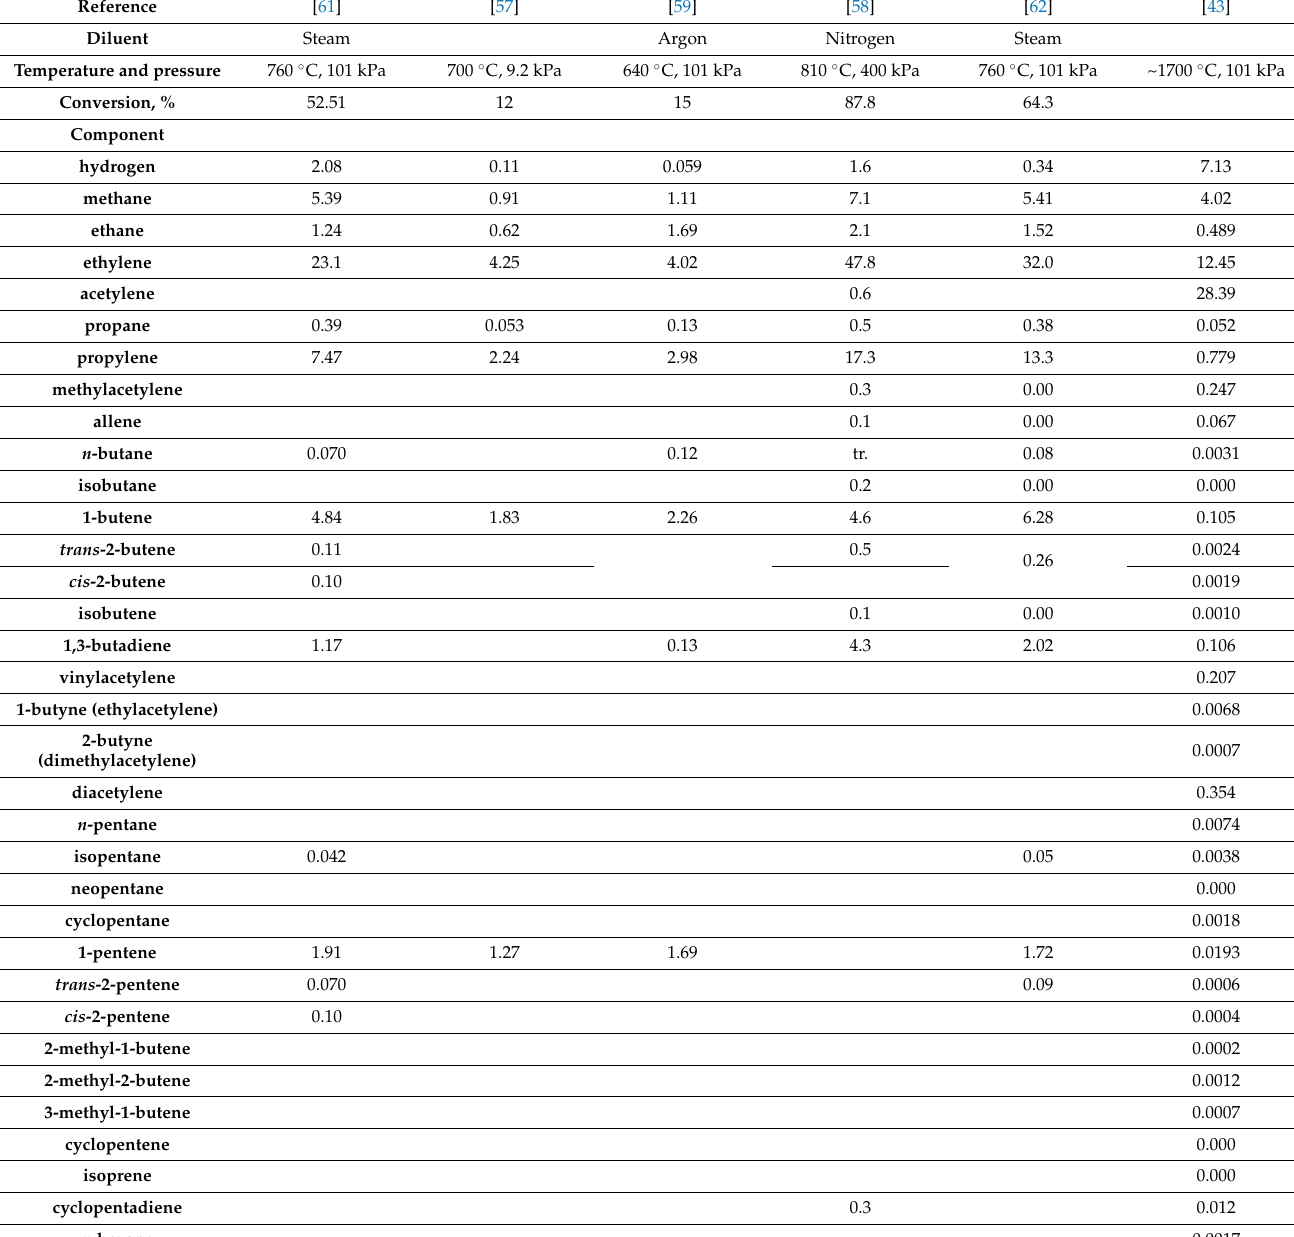
Table 1. Comparison of distributions of gas-phase products in pyrolysis of n -heptane [57,58,61,62] and microwave dis- charge in liquid n -heptane [43]. All values are given in wt. % (all data were recalculated on the basis of data from the original